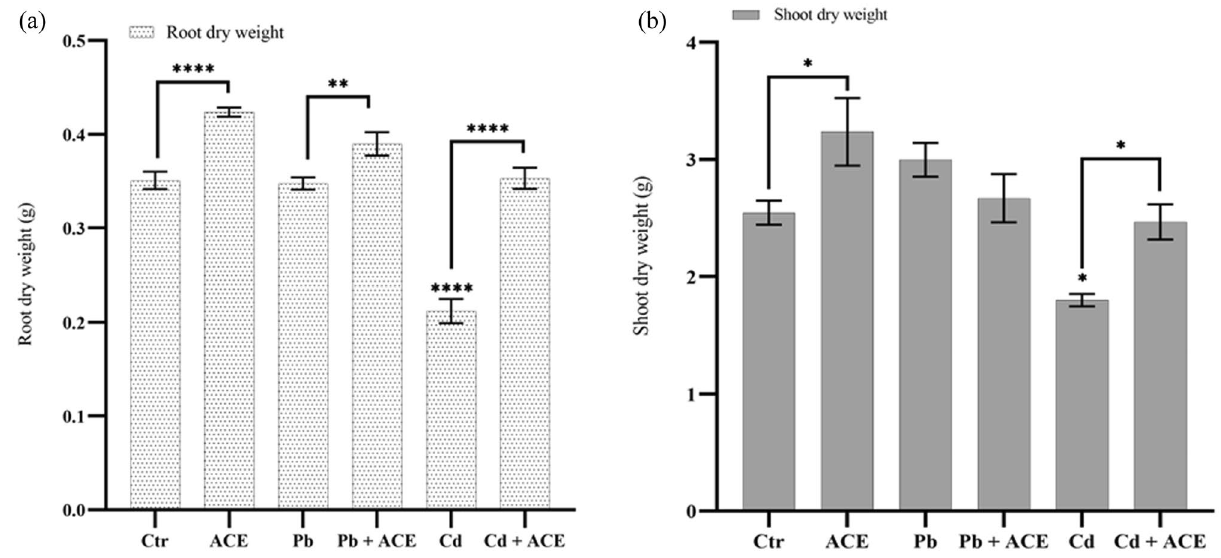
Figure 1. Effect of ACE on tomato root ( a ) and shoot ( b ) dry matter under Pb and Cd stress (Figure generated by GraphPad prism 9 software, while “*” indicates statistical significance ( P < 0.05); “**” indicates statistical significance ( P < 0.01); “****” indicates statistical significance ( P =